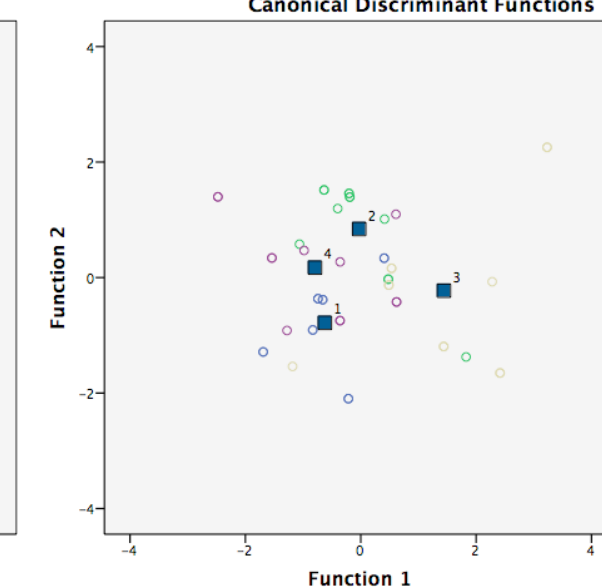
Fig. 1. Dynamics of test results in boys aged 8. CTE3: 1 – load variant І, 2 – load variant ІІ, 3 – load variant ІІI, 4 – load variant